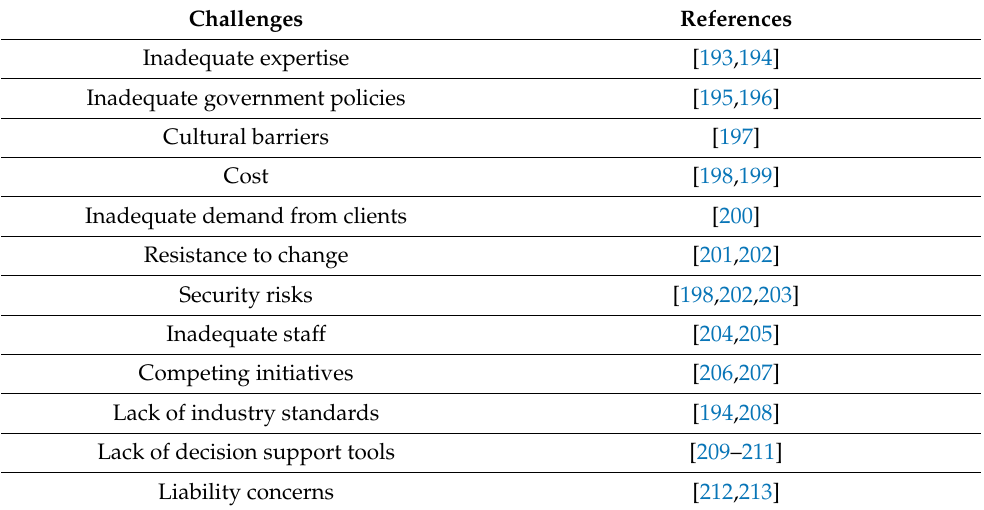
Table 5. DTS adoption challenges in the AEC